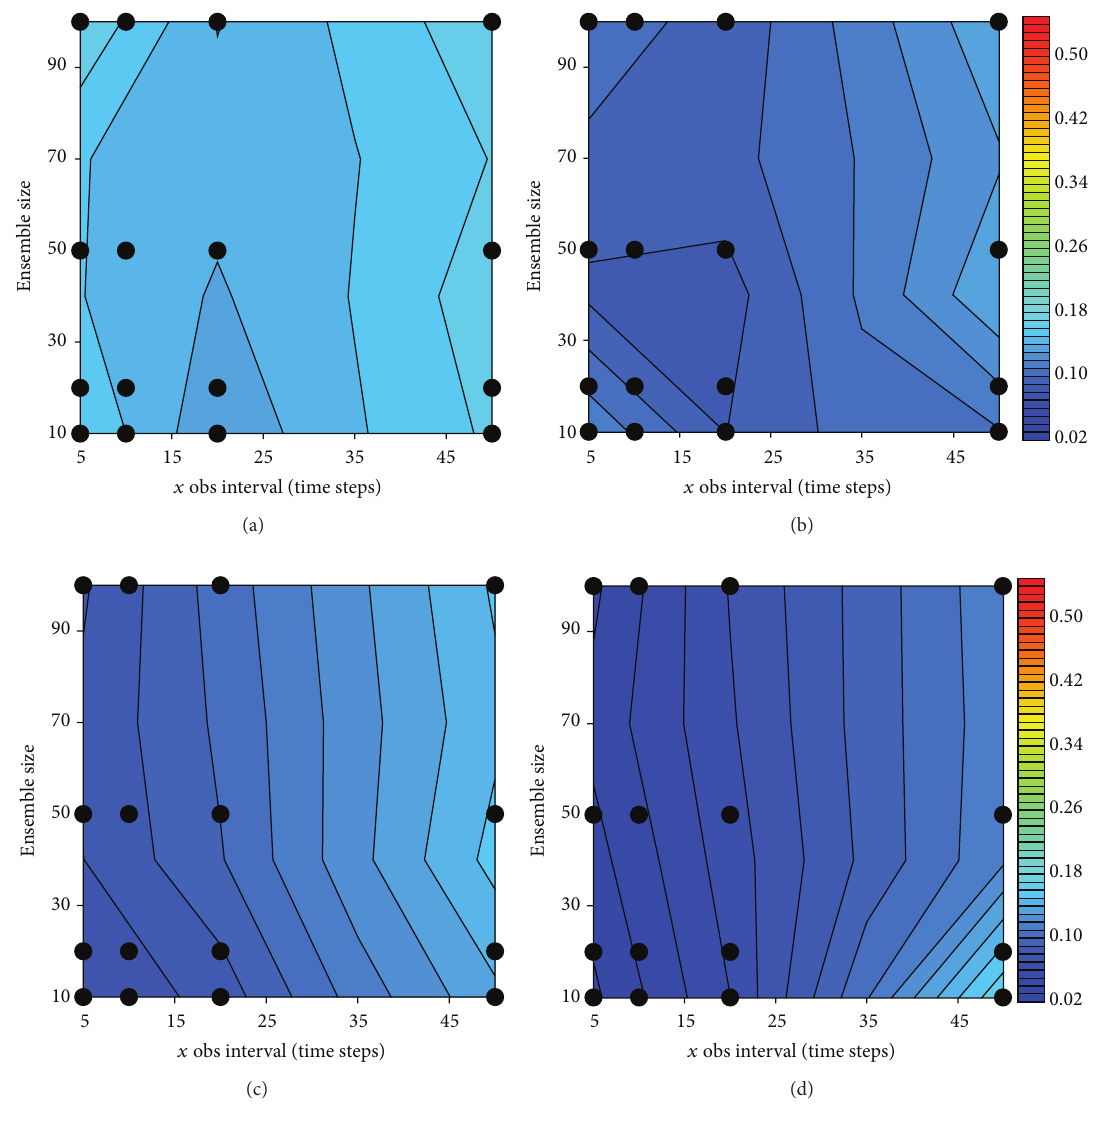
Figure 9: Same as Figure 5 but for the EnKF